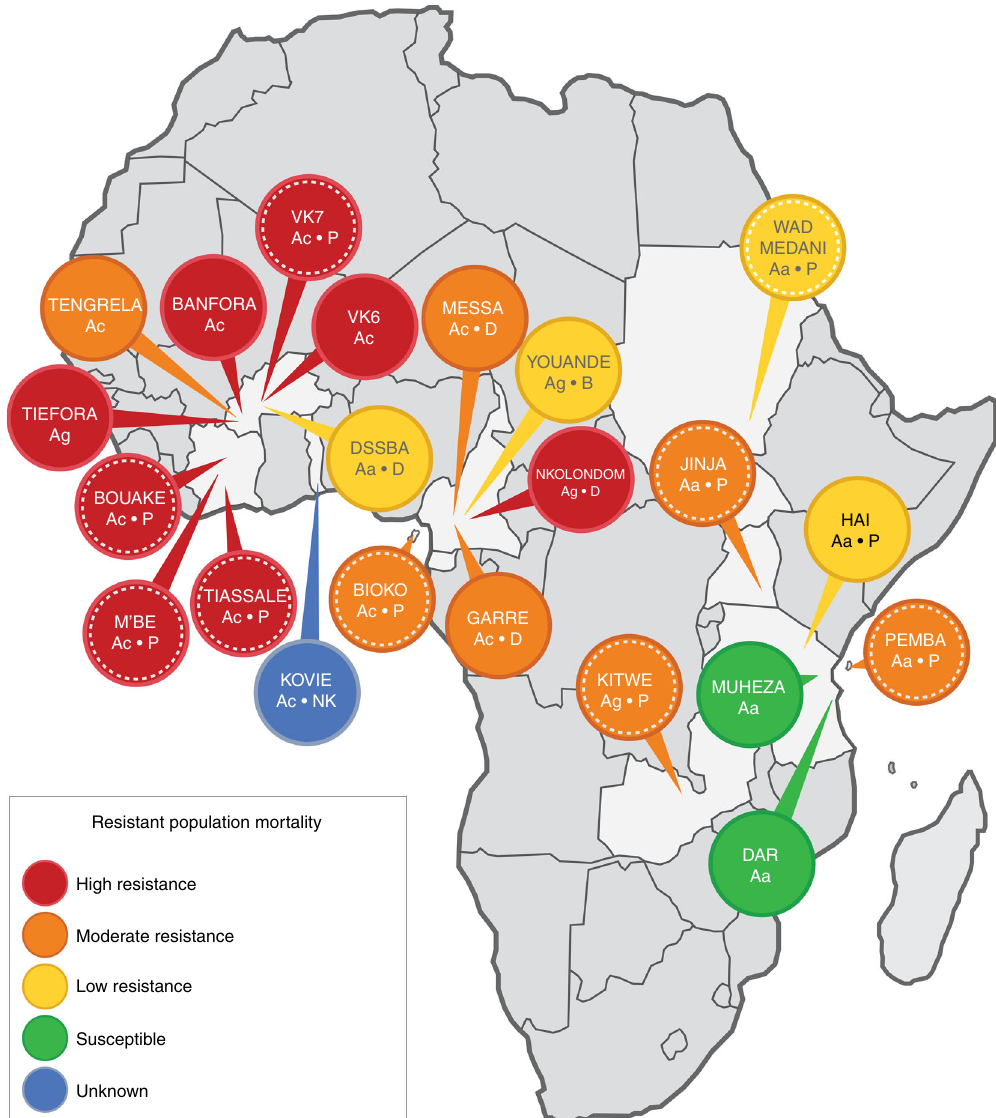
Fig. 1 Distribution of available microarray datasets. Microarray datasets available from sub-Saharan Africa comparing insecticide resistant and susceptible: An. gambiae (Ag), An. coluzzii (Ac) or An. arabiensis (Aa). Resistance levels are characterised by the populations maximal recorded mortality in WHO discriminating dose assays: high resistance 0 – 33% mortality, moderate resistance 33 – 66%, low resistance 66 – 90% mortality, susceptible populations are those that consistently exhibited 100% mortality after exposure (See Supplementary Table 1). The insecticides that the populations have been exposed to prior to RNA extraction are represented by D DDT, P Pyrethroid, B Bendiocarb, NK Not known; unexposed mosquitoes have no corresponding letter. Figure created expressly for this manuscript by Manuela